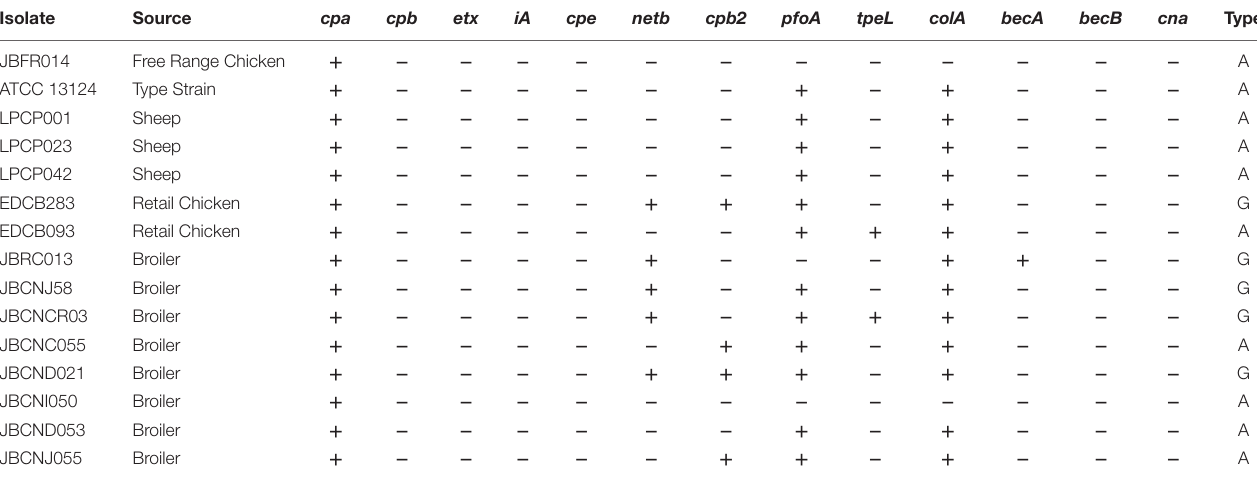
TABLE 2 | Clostridium perfringens toxin profiles of strains and isolates used within this study. Isolate